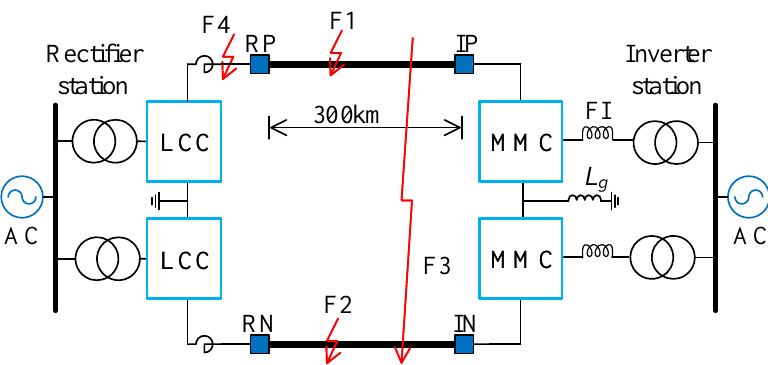
Figure 6. PSCAD simulation case.